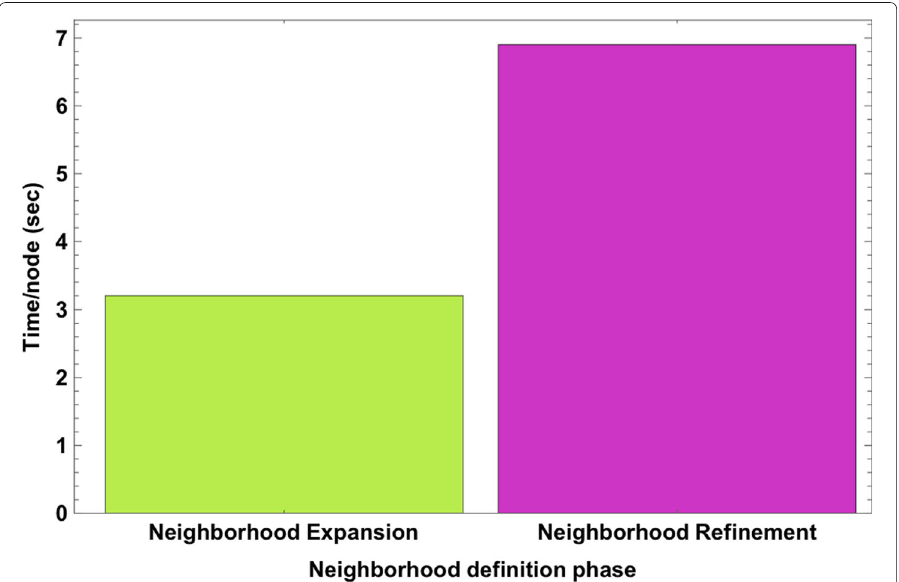
Fig. 6 Runtime analysis of SURREAL’s neighborhood expansion and refinement phases, per node, of Wikipedia dataset. The | N E ( u ) | = 1,200 and | N R ( u ) = 800 | . The refinement process represents a bottleneck that renders SURREAL less